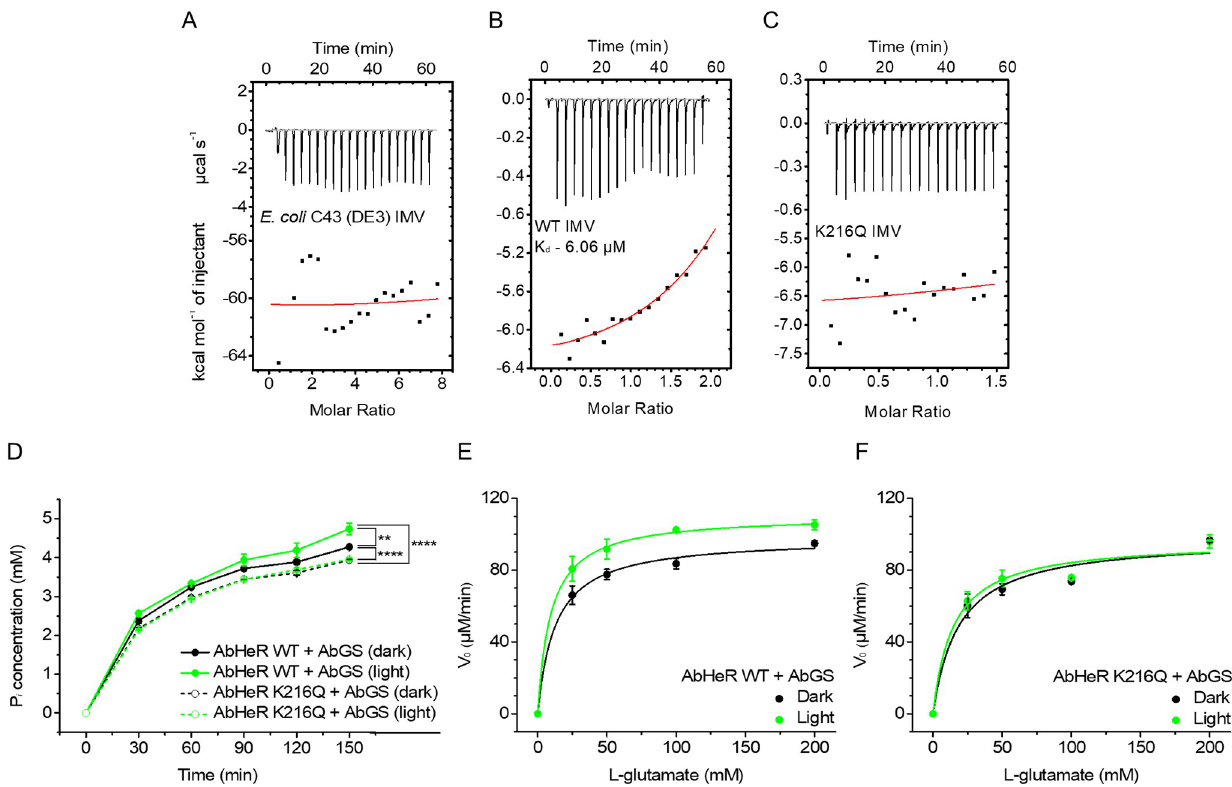
Fig 3. AbGS activity is regulated in vitro via AbHeR binding. The binding of AbGS to preparations of Escherichia coli C43 (DE3) (A), AbHeR WT (B), and AbHeR K216Q (C) IMVs were analyzed by ITC analysis. The upper and lower panels represent the raw data and enthalpy change per mol, respectively. AbGS was continuously added to IMVs. The nonlinear curves of the lower panels were evaluated by best-fit curve analysis. (D–F) AbGS reactions were performed with AbHeR WT and K216Q IMV in the absence (dark) and presence of light (light, 532 nm) for time traces at 30 μ mol m -2 s -1 using a biosynthesis assay. The nonlinear and linear fits were evaluated using the Michaelis–Menten equation (E and F). (D) Biosynthesis assay of AbGS reactions with AbHeR WT IMV carried out with 100 mM L-glutamate at different times. The measurements were conducted in an independent experimental group ( n = 6), and the data are expressed as mean ± standard deviation. The statistical significance between the 2 groups was analyzed using the t test; p -values are indicated by an asterisk. The underlying data of the ITC analysis and the biosynthesis assay can be found in S1 and S2 Data, respectively. IMV, inverted membrane vesicle; ITC, isothermal titration calorimetry; WT, wild